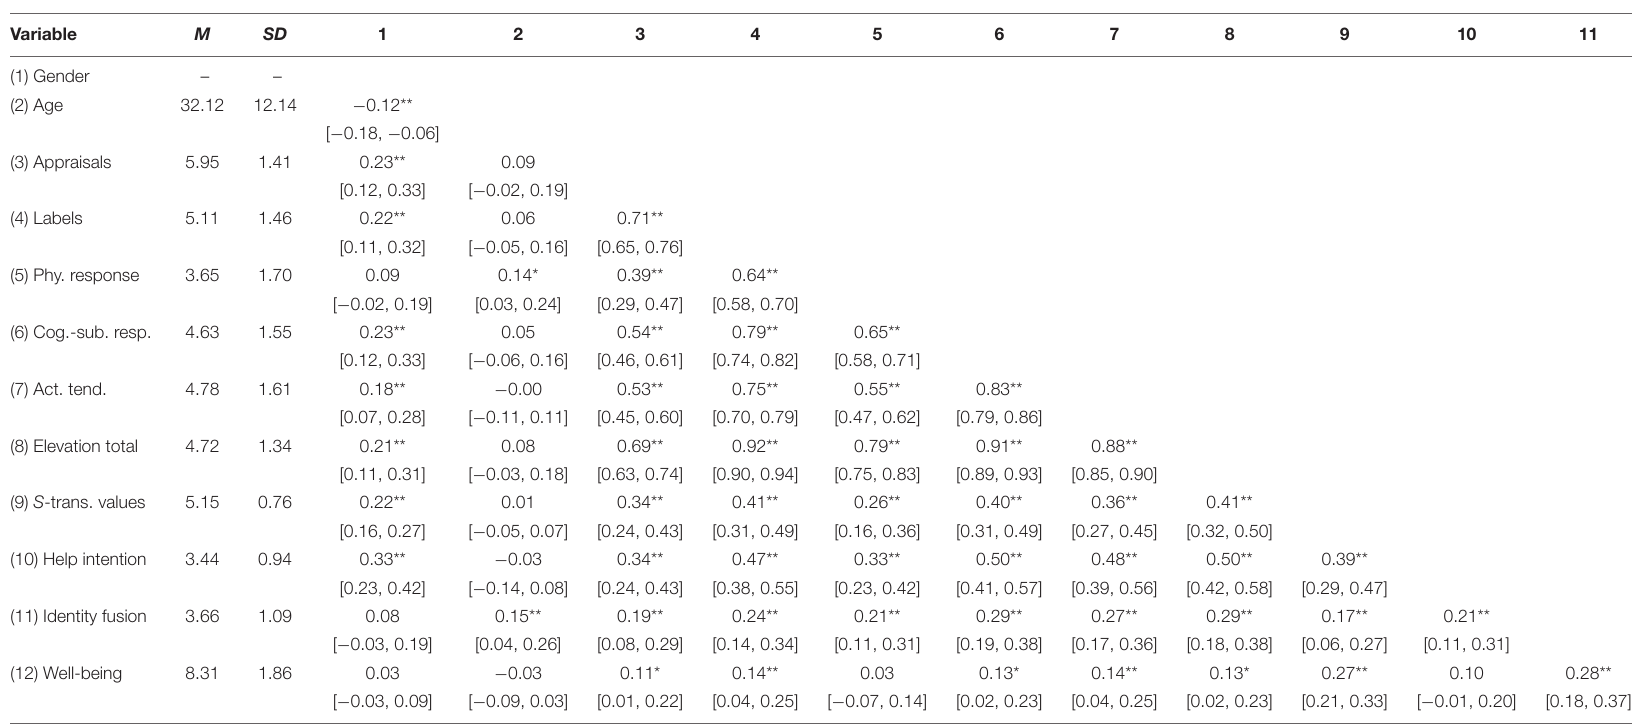
TABLE 4 | Descriptive and correlation analyses of interest variables after answering the elevation prototypical video. Variable